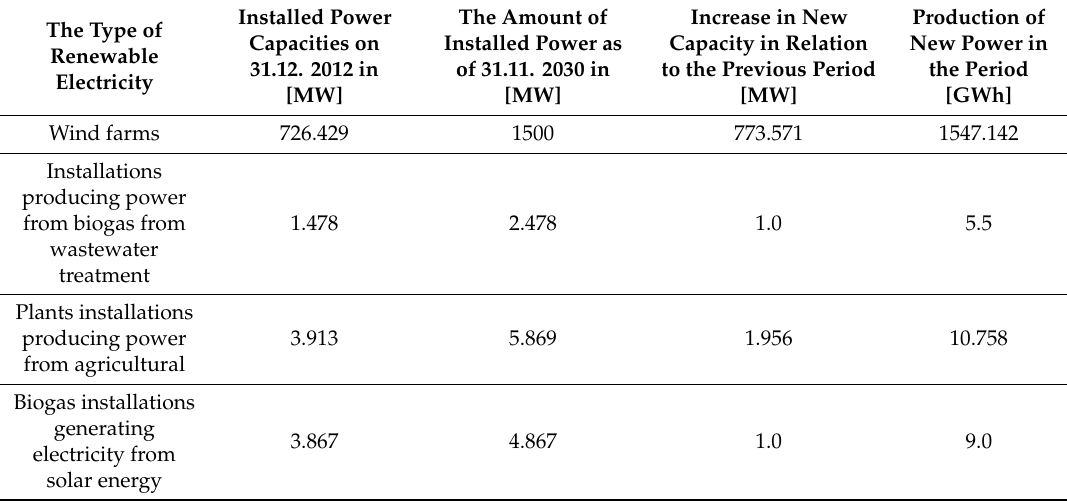
Table 13. Increase of new installed renewable electricity capacities in the West Pomeranian Region in 2012–2030 according scenario II.